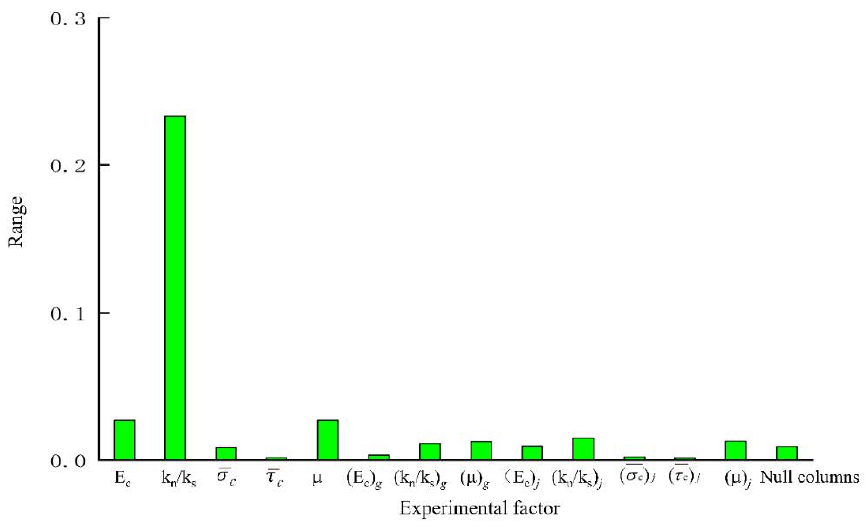
Figure 9. Results of analysis of range of elastic modulus.